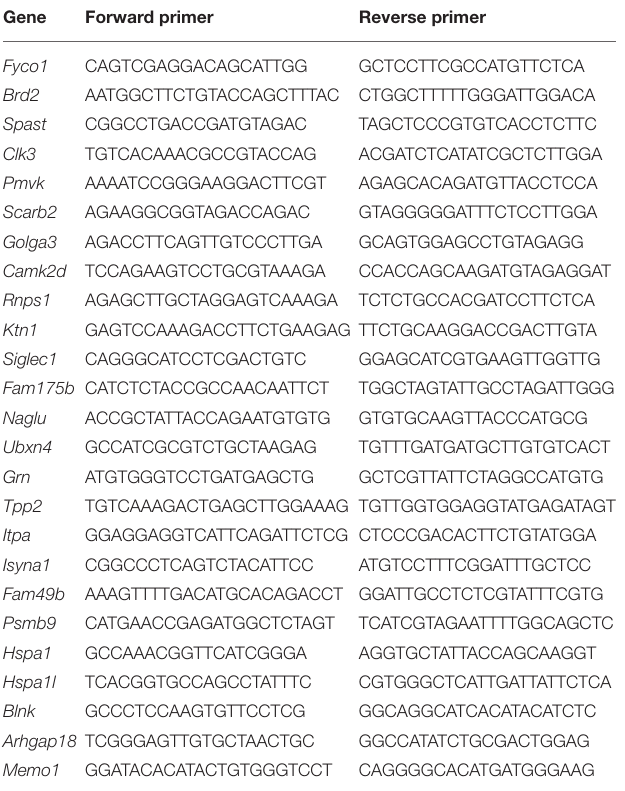
TABLE 1 | List of primers used in experiments.